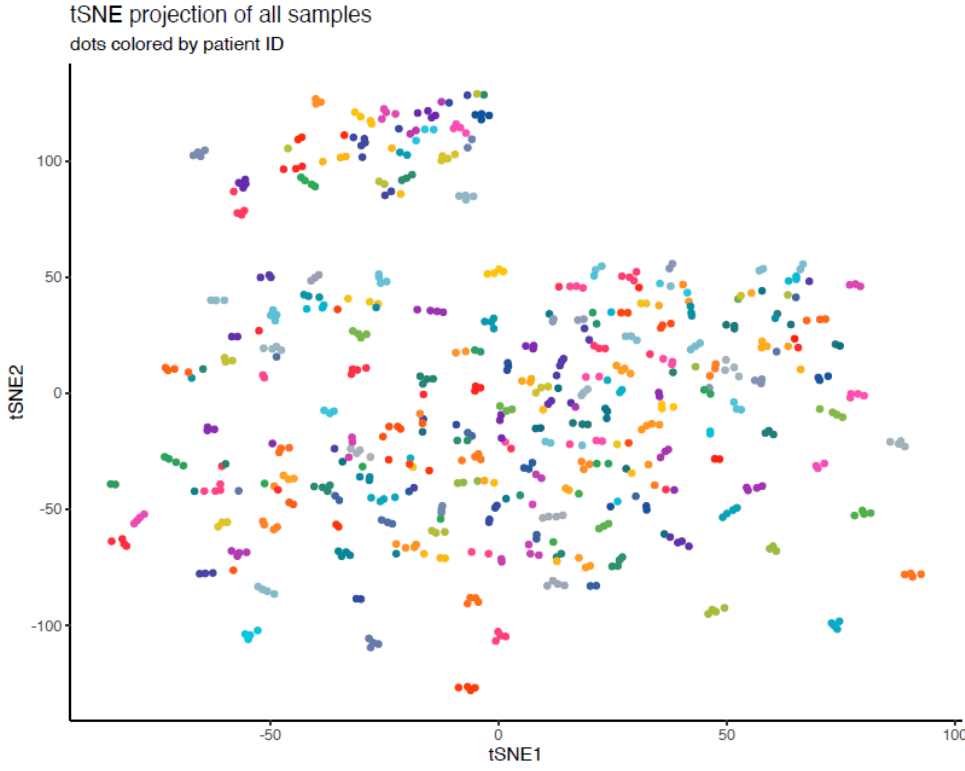
Figure 3. tSNE projection of the dataset after omission of outliers and samples failing quality control.